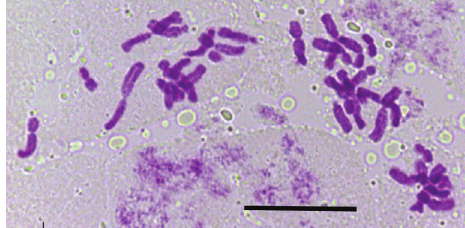
Figure 13. Helleborus viridis L. subsp. abruzzicus (M.Thomsen, McLewin & B.Mathew) Bartolucci, F.Conti & Peruzzi, 2 n = 32. Scale bar: 10